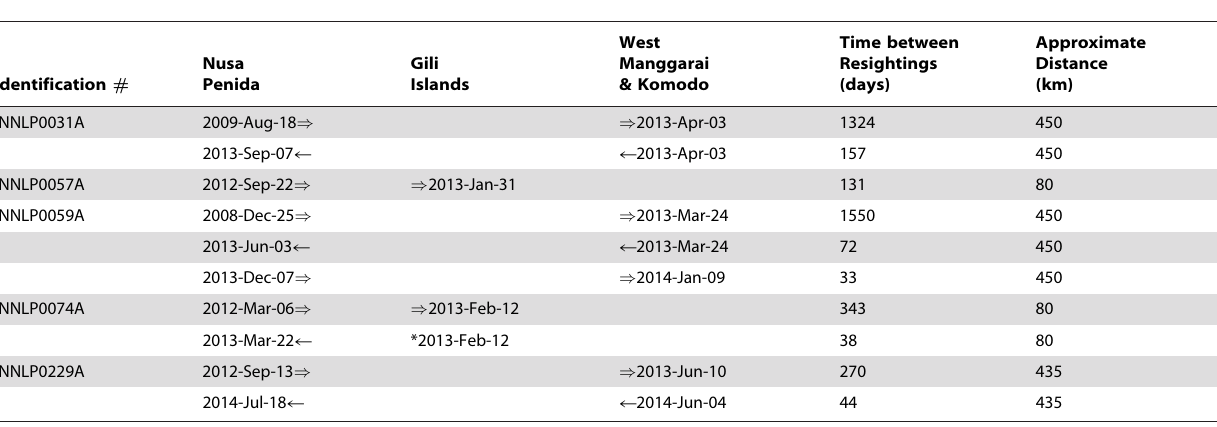
Table 2. The sighting records of individual rays migrating between Nusa Penida and Gili Islands or West Manggarai & Komodo